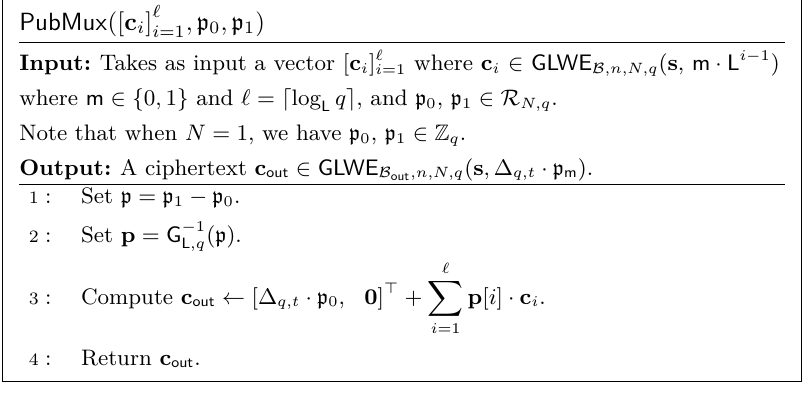
Figure 1: Public Mux algorithm